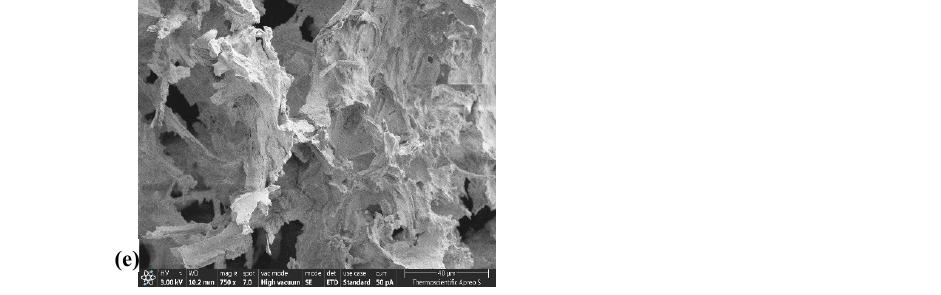
Figure 4. Scanning electron micrographs of bark fiber pretreatment with various concentrations of PA; ( a ) Untreated bark fiber, and that treated with ( b ) 70% PA, ( c ) 75% PA, ( d ) 80% PA, and ( e ) 85% PA.